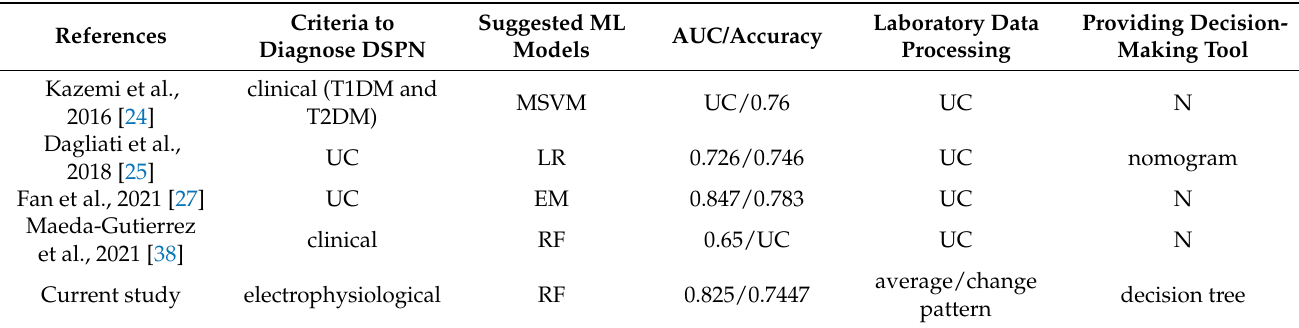
Table 7. Comparison of previous studies that used machine learning algorithms to predict DPSN in type 2 diabetes mellitus